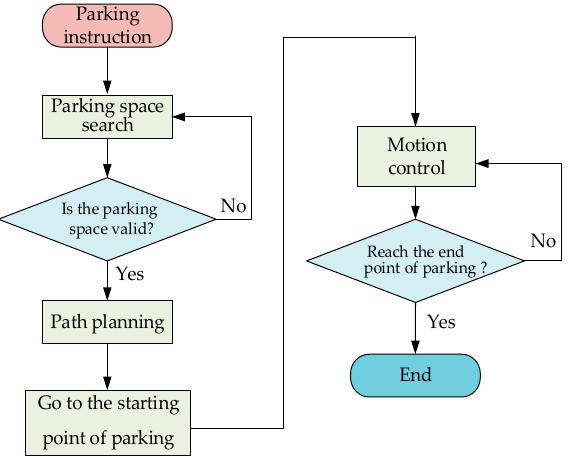
Figure 2. The working process of autonomous parking system.